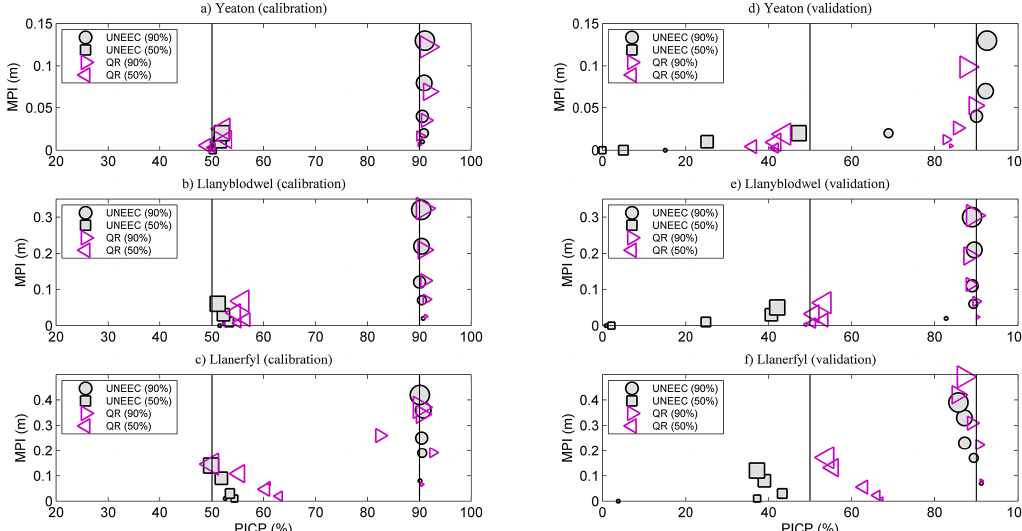
Figure 12. Comparison of UNEEC and QR based on both PICP and MPI during calibration period (7 March 2007, 08:00UTC–7 March 2010, 08:00UTC) and validation period (7 March 2010, 20:00UTC–7 March 2013, 08:00UTC) for the 90% and 50% confidence levels. (The size of the marker represents the lead time; i.e. the bigger the marker, the longer the lead time.)